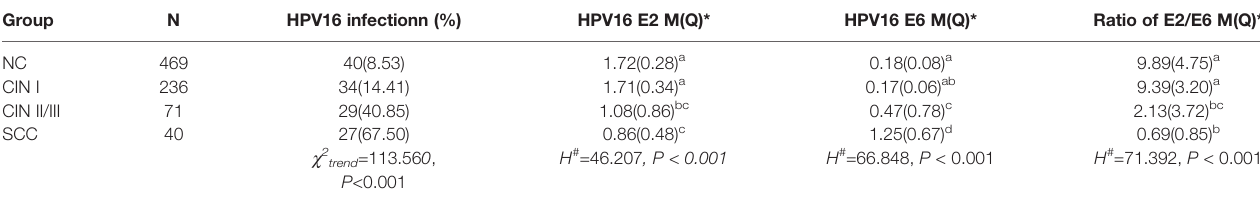
TABLE 1 | Associations between HPV16 genes expression and cervical lesions.